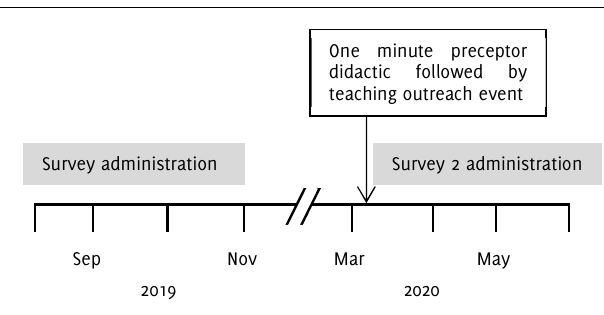
Figure 1 . Flow of Study